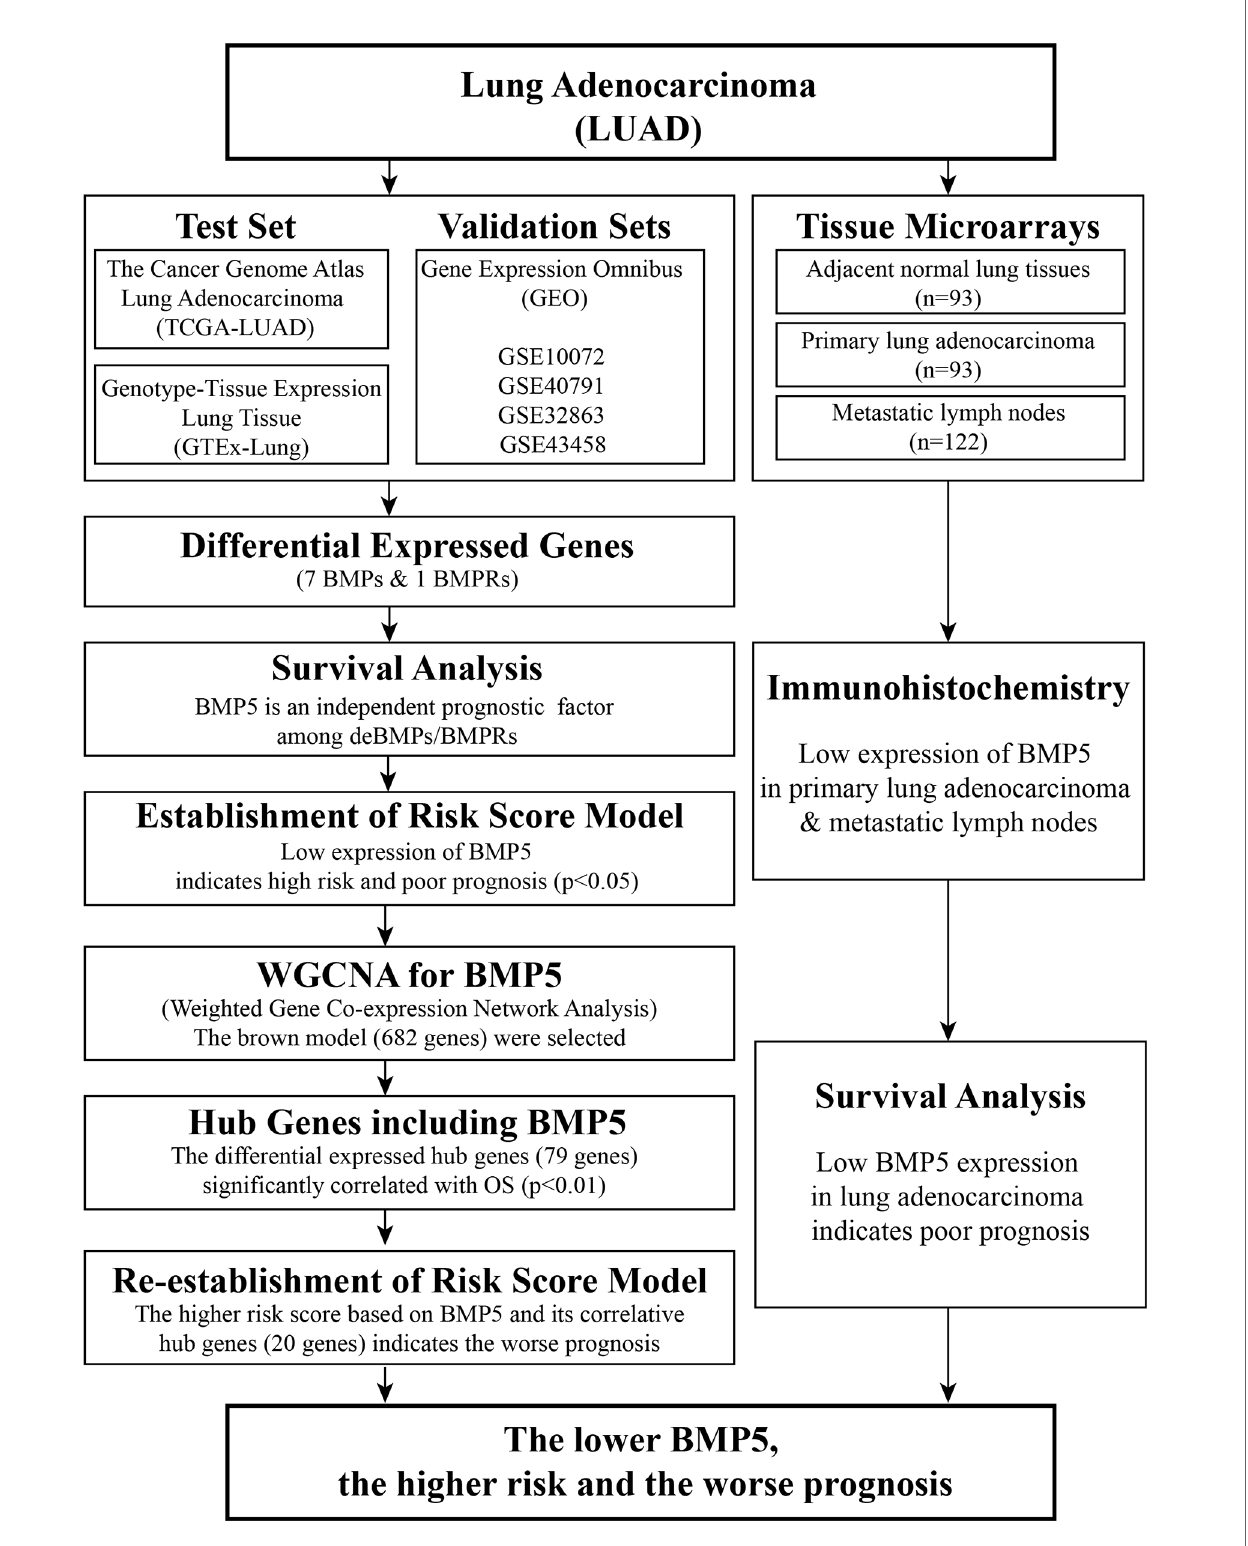
FIGURE 1 | Work fl ow of identi fi cation of differentially expressed bone morphogenetic proteins (BMPs)/bone morphogenetic protein receptors (BMPRs) and evaluation of their prognostic value in lung adenocarcinoma.